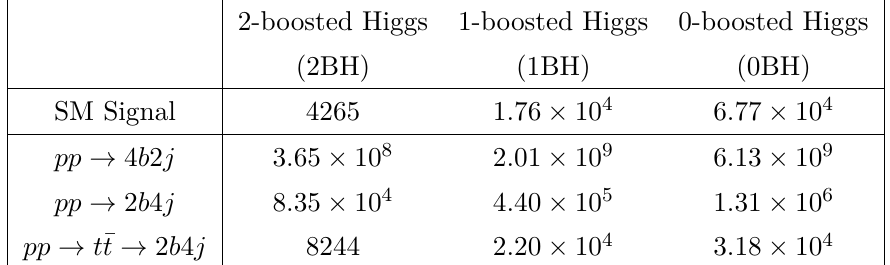
Table 5 . The cut efficiencies of b-tagging and VBF at 100 TeV collider are demonstrated. Here, the total integrated luminosity is assumed to be L = 30 ab − 1 . b-tagging efficiency is (cid:15) miss tagging rate is (cid:15) = 0 . 001 . miss